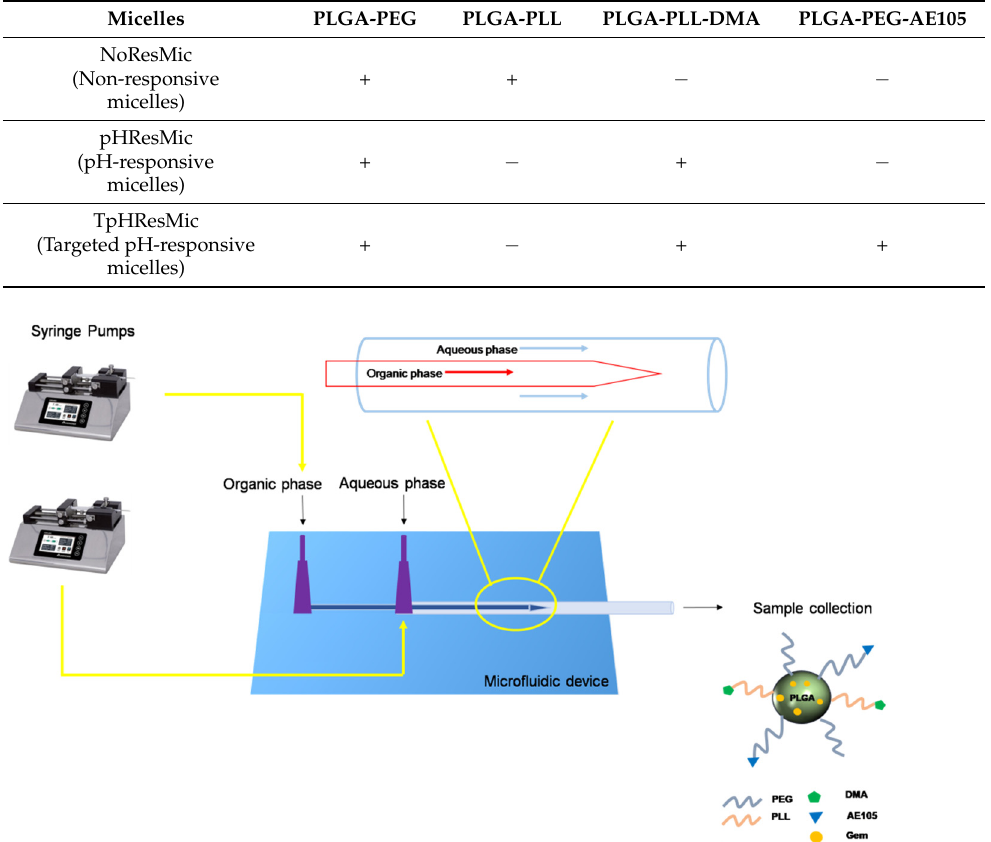
Table 1. Description of the polymeric composition of micelles. +: present in the formulation, − : not present in the formulation.